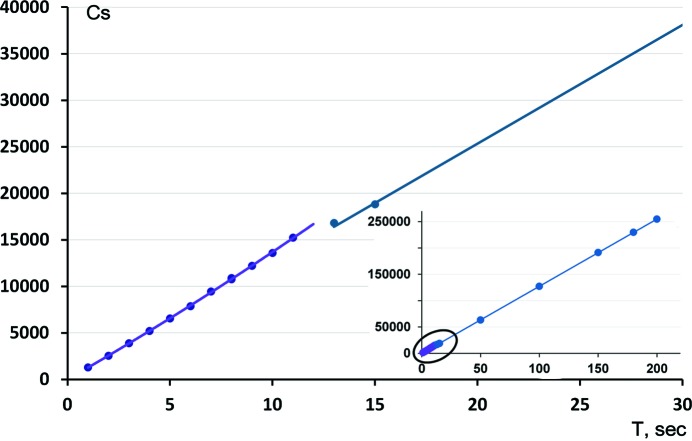
Calibration curve for the response of PMT1 and PMT2. The full calibration curve is shown in the inset.